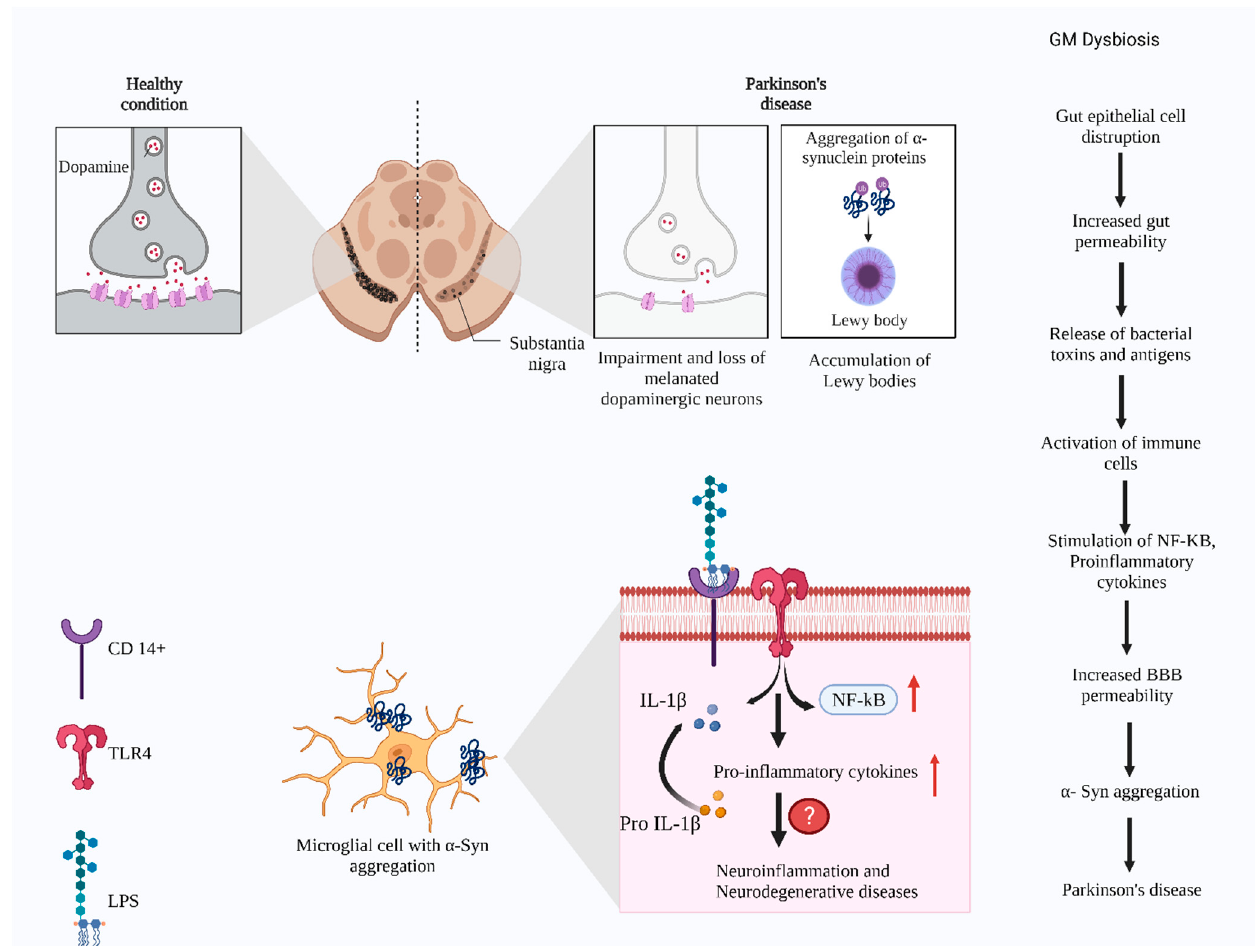
Figure 4. The representation of molecular signaling and progression of Parkinson’s disease in sub- stantia nigra. Gut dysbiosis activates the immune system. The released cytokines may disturb the blood–brain barrier, facilitating the entry of bacterial metabolites and other antigens to the central nervous system. It causes α -syn aggregation in the substantia nigra of the brain. Hyperphosphory- lated α -syn recruits the TLR4 and CD14+ in the microglial cells, promoting the neuronal immune responses by activating the NF- κ b, pro-IL β pro-inflammatory cytokines. The exact mechanism and the players are not elucidated completely (Figure created using BioRender.com).